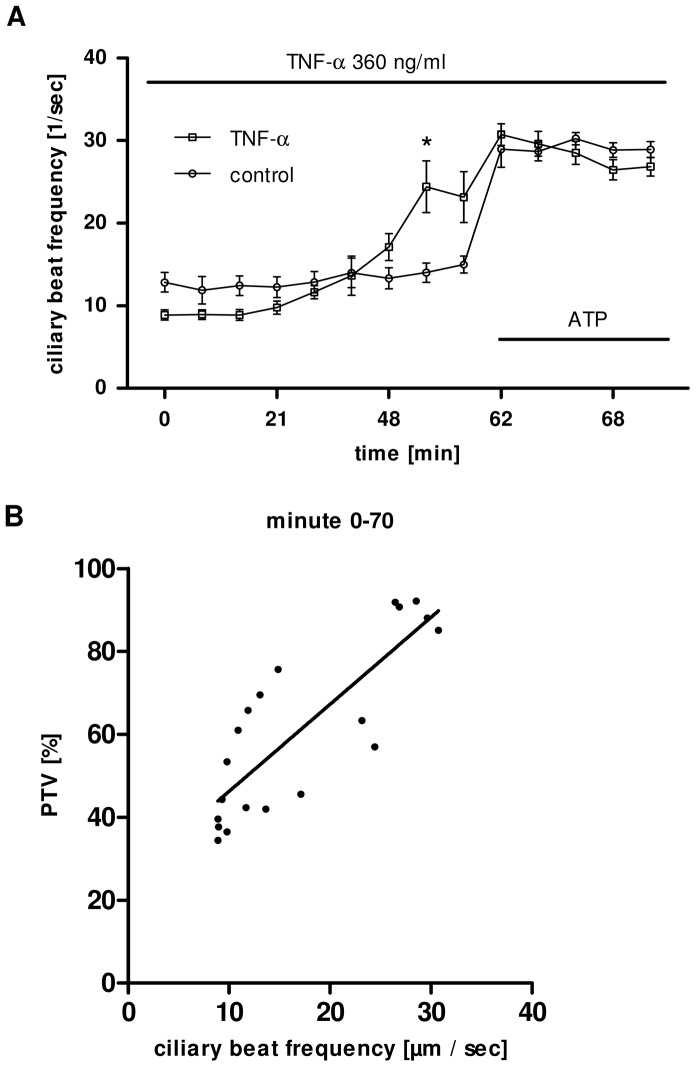

A: TNF-α increases CBF. Under control conditions no changes in CBF were observed. Here only the application of TNF-α (360 ng/ml, n = 5) at minute 0 is shown this responded by a rapid increase in CBF, that became significant from minute 48 (p<0.05), reaching its maximum at minute 57 (before ATP application, p<0.05) compared to control (n = 5). (Mann Whitney U-test (Mean ± S.E.M.). B: Correlation of cilia driven particle transport with CBF. Increase of CBF (mean values; n = 5) during the exposure to TNF-α (360 ng/ml) strongly correlates (r = 0.83, p<0.001) with the parallel increase in PTV (mean values; n = 5) during the chosen observation period (Spearman correlation test for nonparametric correlation).